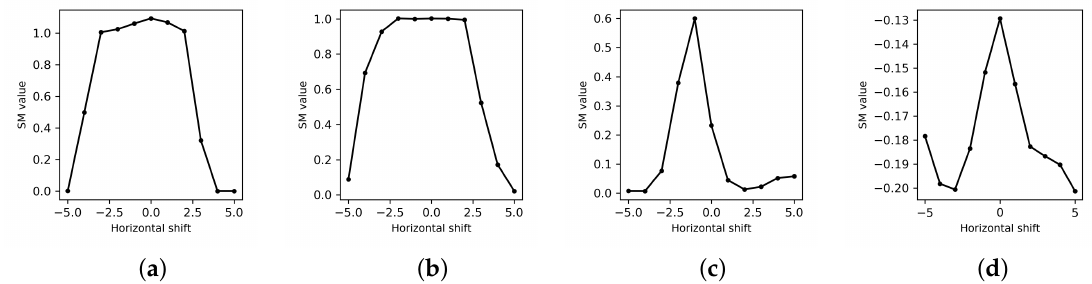
Figure 2. Shape of SMs as a function of horizontal translation between a pair of similar patches: ( a ) hinge loss, ( b ) L 2 loss, ( c ) multiclass loss, and ( d ) MIND SM. For patch matching CNN with hinge and L 2 losses, unity SM value means high similarity; zero SM value means no similarity. For patch matching CNN with multiclass loss, higher SM values correspond to higher similarity. Patch matching CNN structure is described in Section 3.4. For MIND, lower SM values mean higher similarity. Inverse MIND value is shown for consistency. Profiles are obtained for a pair of similar visual and infrared patches from Landsat 8 and Sentinel 2 sensors. SMs values are calculated by mutually shifting RP and TP by an integer number of pixels in horizontal direction in interval − 5...5